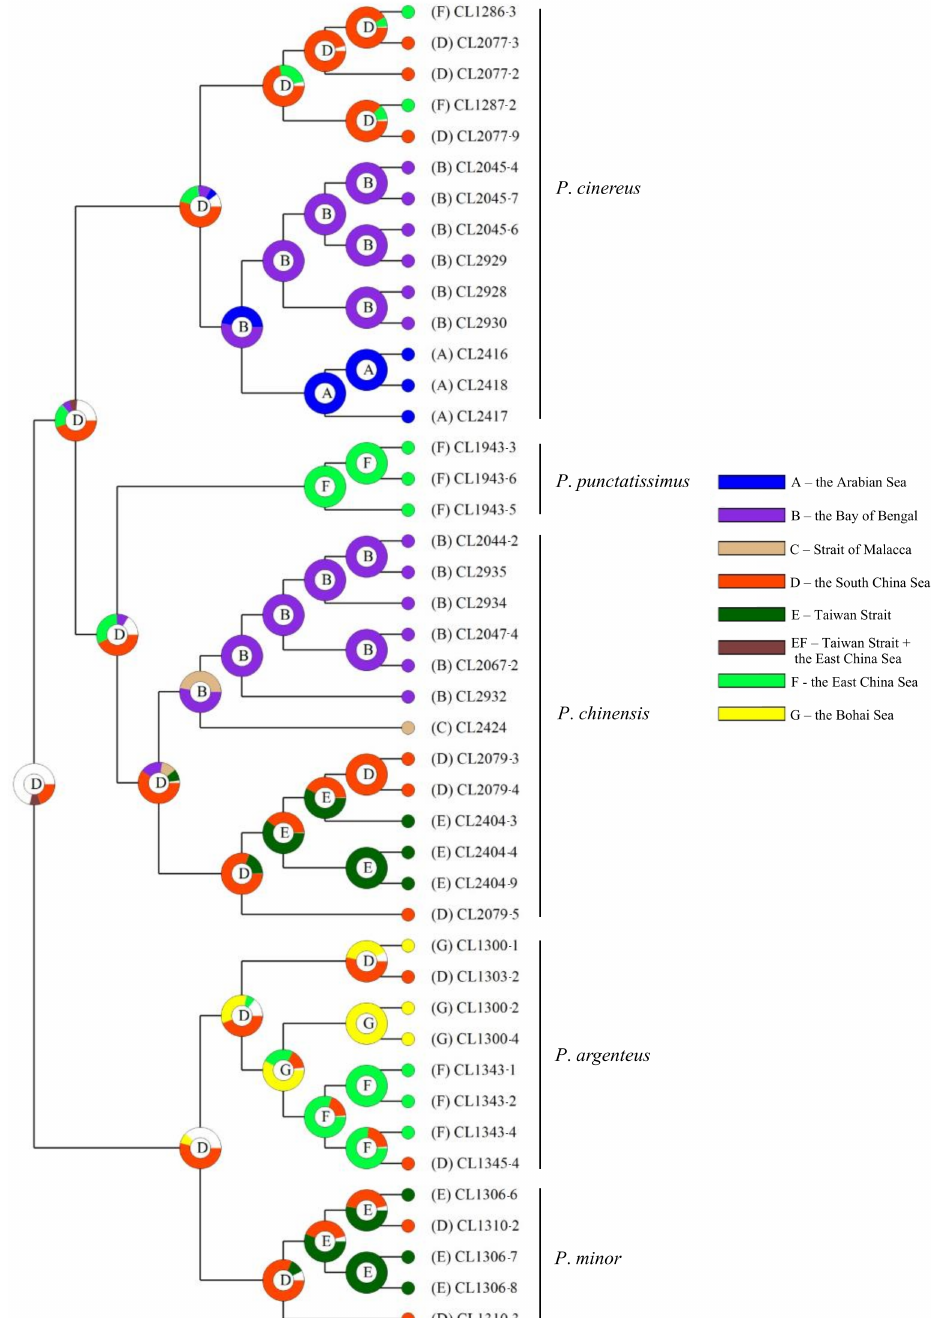
Figure 8. Result of ancestral area reconstruction, indicating that the South China Sea was the origin of the genus Pampus . Letters inside the pie charts indicate the most likely sites of origin. Only the areas with probability > 5% are shown in the pie charts. Sampling locations represented are as follows: A, the Arabian Sea; B, the Bay of Bengal; C, Strait of Malacca; D, the South China Sea; E, the Taiwan Strait; F, the East China Sea; G, the Bohai